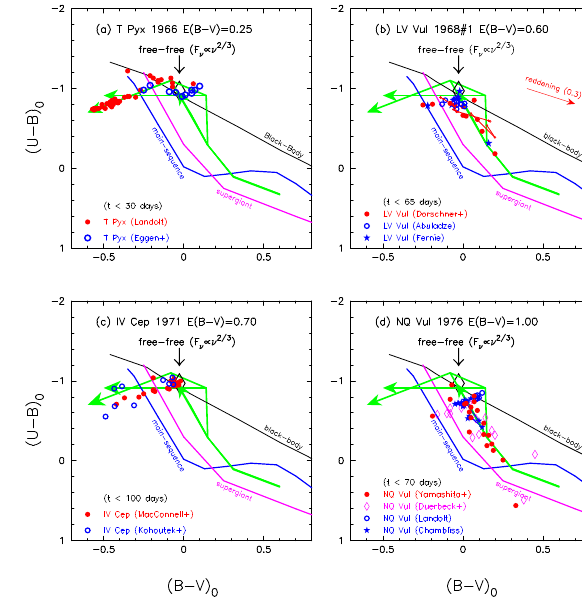
Figure 5: (a) T Pyx, (b) LV Vul, (c) IV Cep, and (d) NQ Vul.